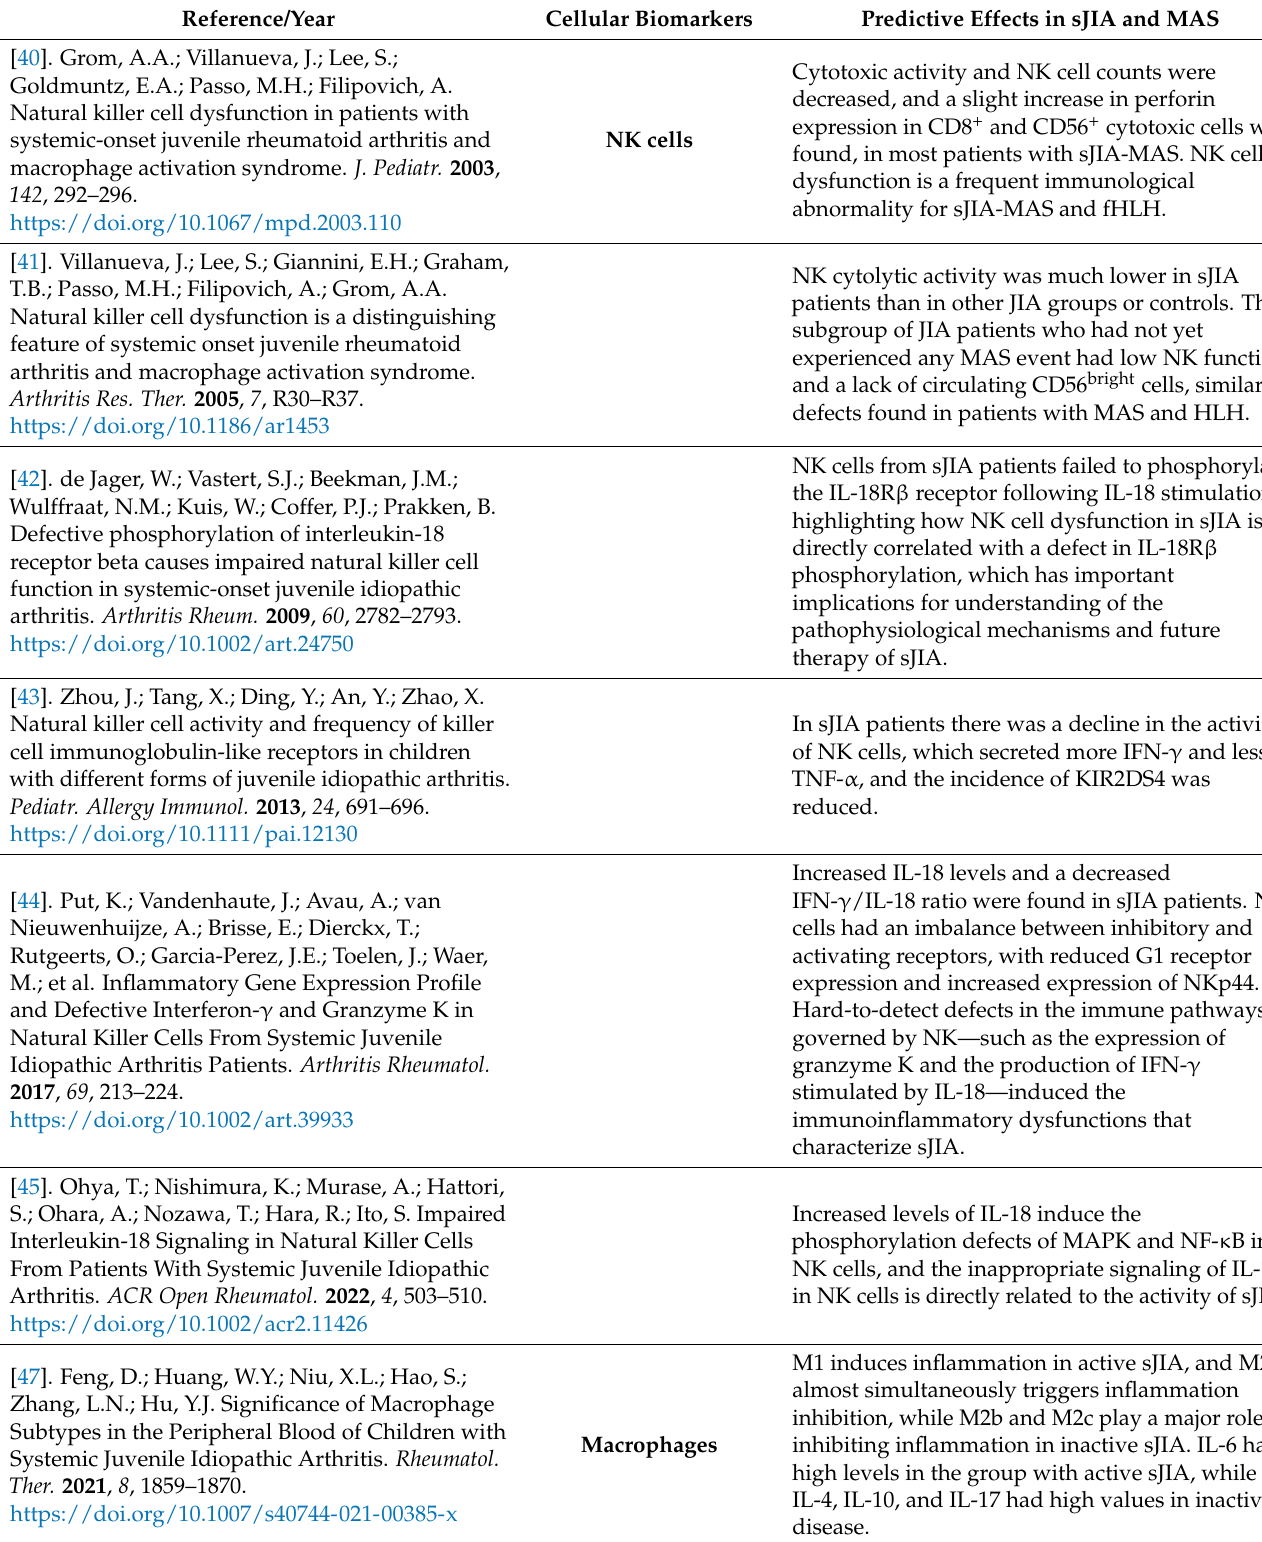
Table 2. Cellular biomarkers proposed for the diagnosis, activity, and prognosis of sJIA and